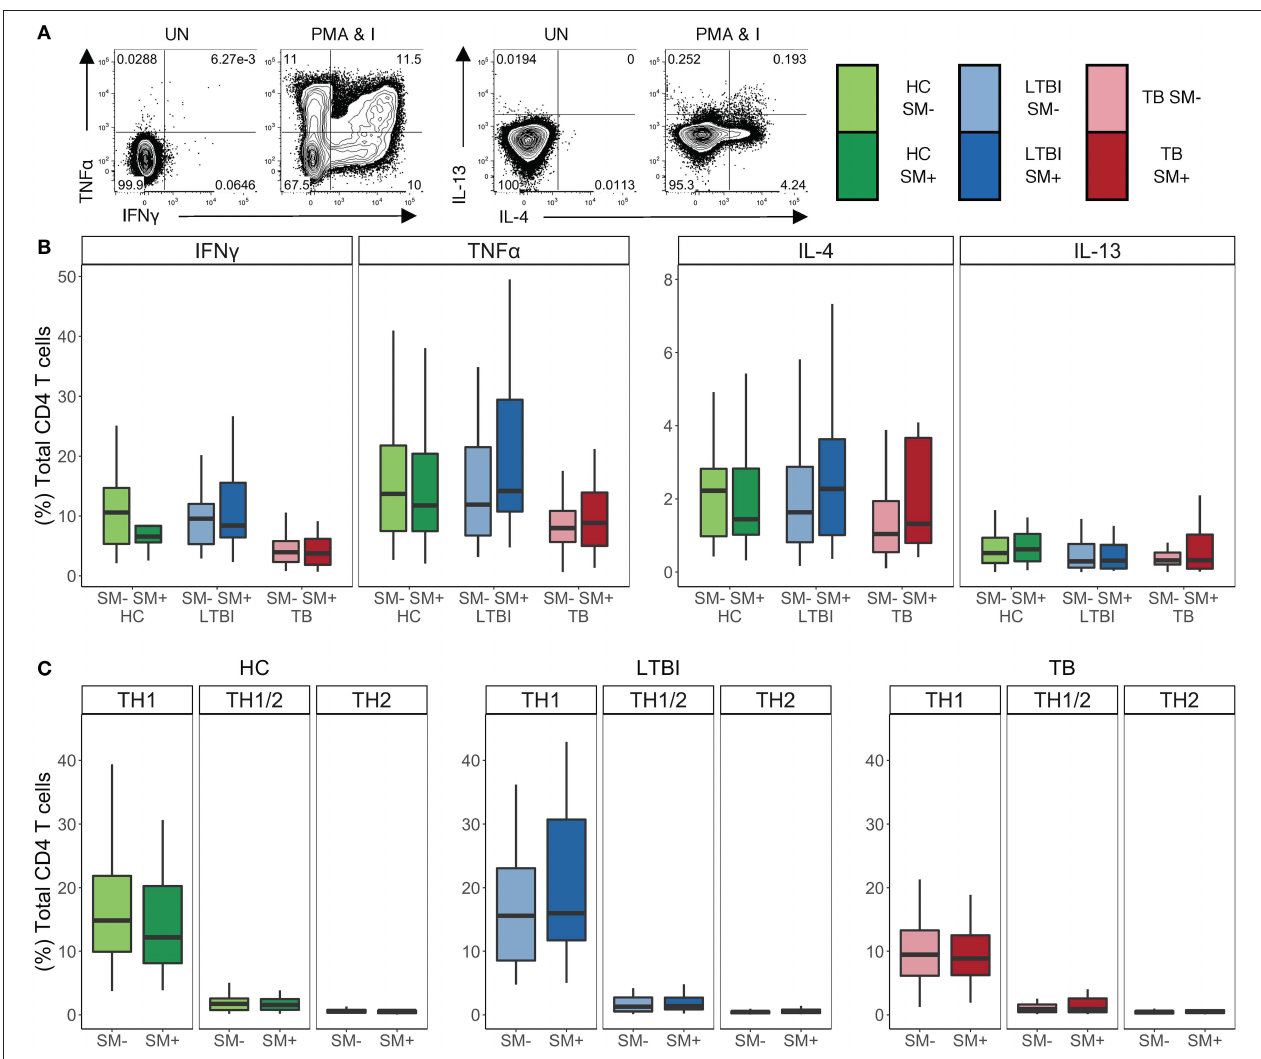
FIGURE 2 | SM + and SM − individuals have similar frequencies of TH1 and TH2 cytokine + CD4T cells, with TH1 cytokines being the dominant response independent of SM and Mtb infection status. PBMC samples obtained from individuals in each of six groups defined by TB and SM infection status were incubated for 18h in media alone (negative control) or stimulated with PMA and ionomycin. Intracellular expression of IFN γ , TNF α , IL-4, and IL-13 was measured by flow cytometry (HC SM − , n = 24; HC SM + , n = 13; LTBI SM − , n = 25; LTBI SM + , n = 25; TB SM − , n = 25; TB SM + , n = 15). (A) Representative flow cytometry data from an SM + HC. Plots are shown gated on live CD3 + CD4 + CD8 − lymphocytes from the unstimulated (UN) and stimulated condition. (B) Frequencies of total CD4T cells expressing each indicated cytokine. (C) Cytokine + cells were aggregated by T cell lineage ( Figure S2 ) and the frequency of each group was reported. Data are shown after subtraction of background cytokine production in the unstimulated negative control condition. Boxes represent the median and interquartile ranges; whiskers represent the 1.5*IQR. Differences in the frequency of each cytokine + CD4T cell population between SM + and SM − individuals were assessed using a Mann Whitney U test. Differences in the frequencies of TH1, TH1/2, and TH2 CD4T cells within each group were evaluated using a Kruskal Wallis test. TH1 cytokine frequencies were statistically higher than the both TH1/2 and TH2 frequencies after applying the Bonferroni correction for multiple